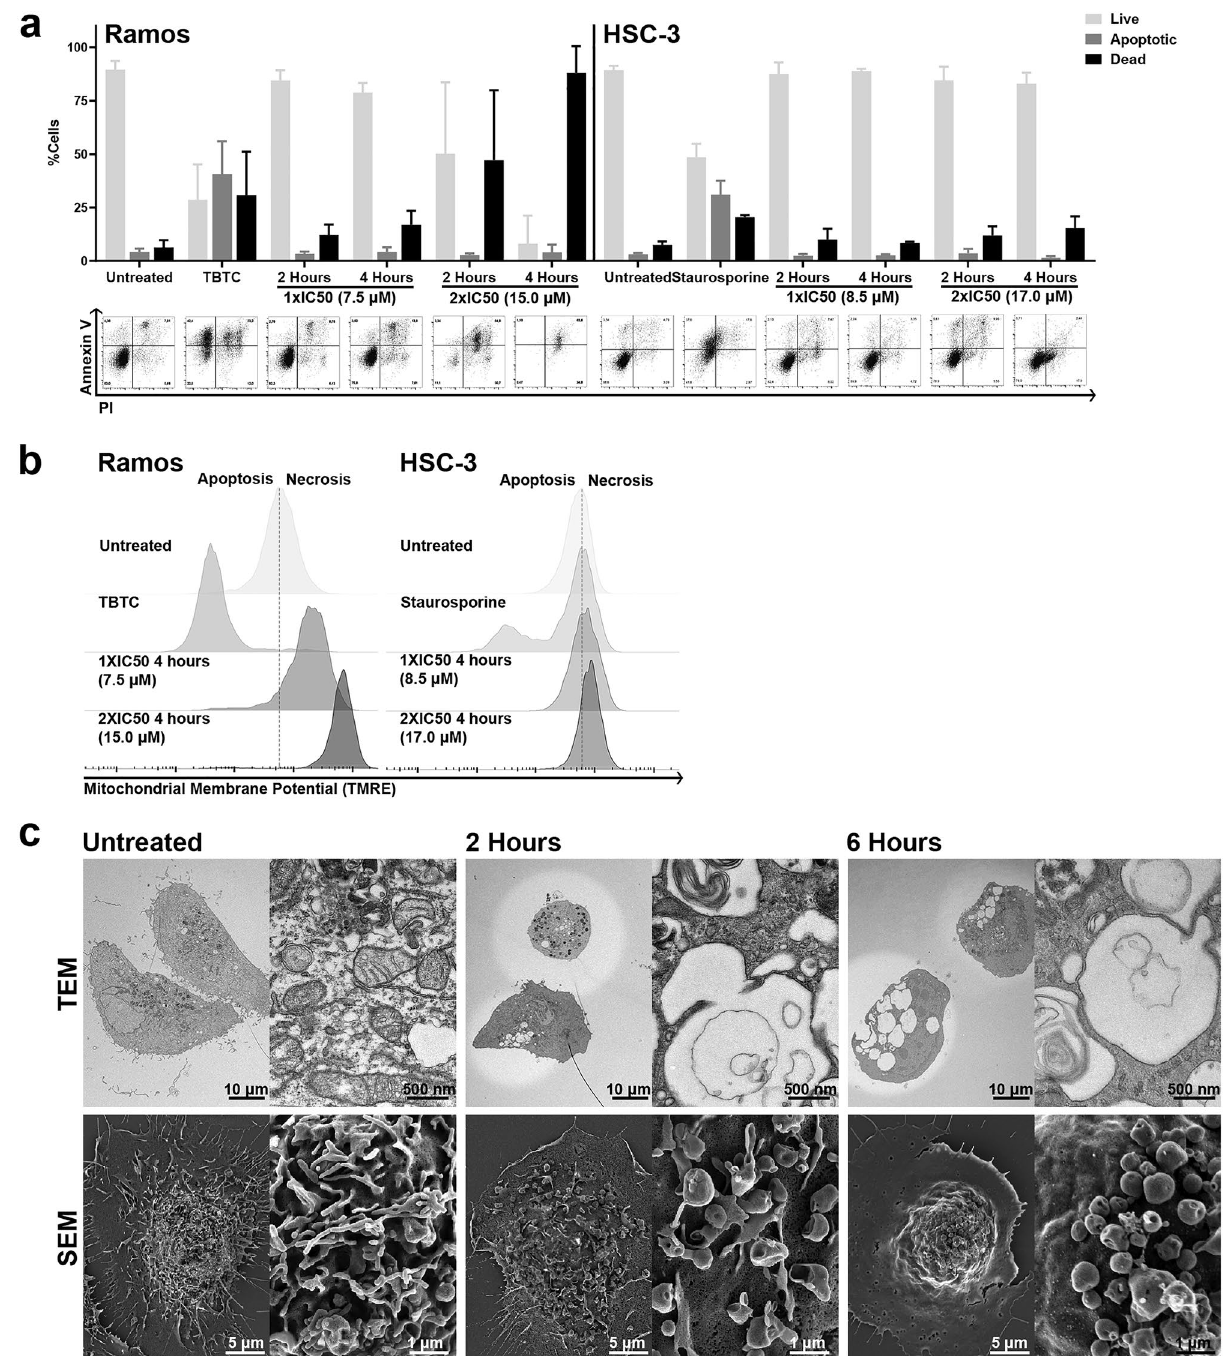
Figure 4. MPM-1 causes necrosis and vacuolization. ( a ) Ramos and HSC-3 cells were analyzed by flow cytometry for cell surface exposure of Annexin V. Cells were treated with 1xIC50 or 2xIC50 MPM-1 for 2 or 4 h. TBTC (2 µM, 2 h) and Staurosporine (100 nM, 24 h) were used as apoptosis controls for Ramos and HSC-3 cells, respectively. The graph shows the percentage of live (PI – /Annexin V – ), apoptotic (PI – /Annexin V + ), and dead (PI + ) cells for each condition, determined from three independent experiments, with error bars representing the standard deviation. ( b ) The mitochondrial membrane potential in Ramos and HSC-3 cells treated with 1xIC50 or 2xIC50 MPM-1 for four hours was assessed by flow cytometric analysis of TMRE fluorescence. The graph illustrates the results from three independent experiments. ( c ) Transmission (TEM) and scanning (SEM) electron microscopy images of untreated HSC-3 cells and HSC-3 cells treated with 1xIC50 MPM-1 for 2 or 6